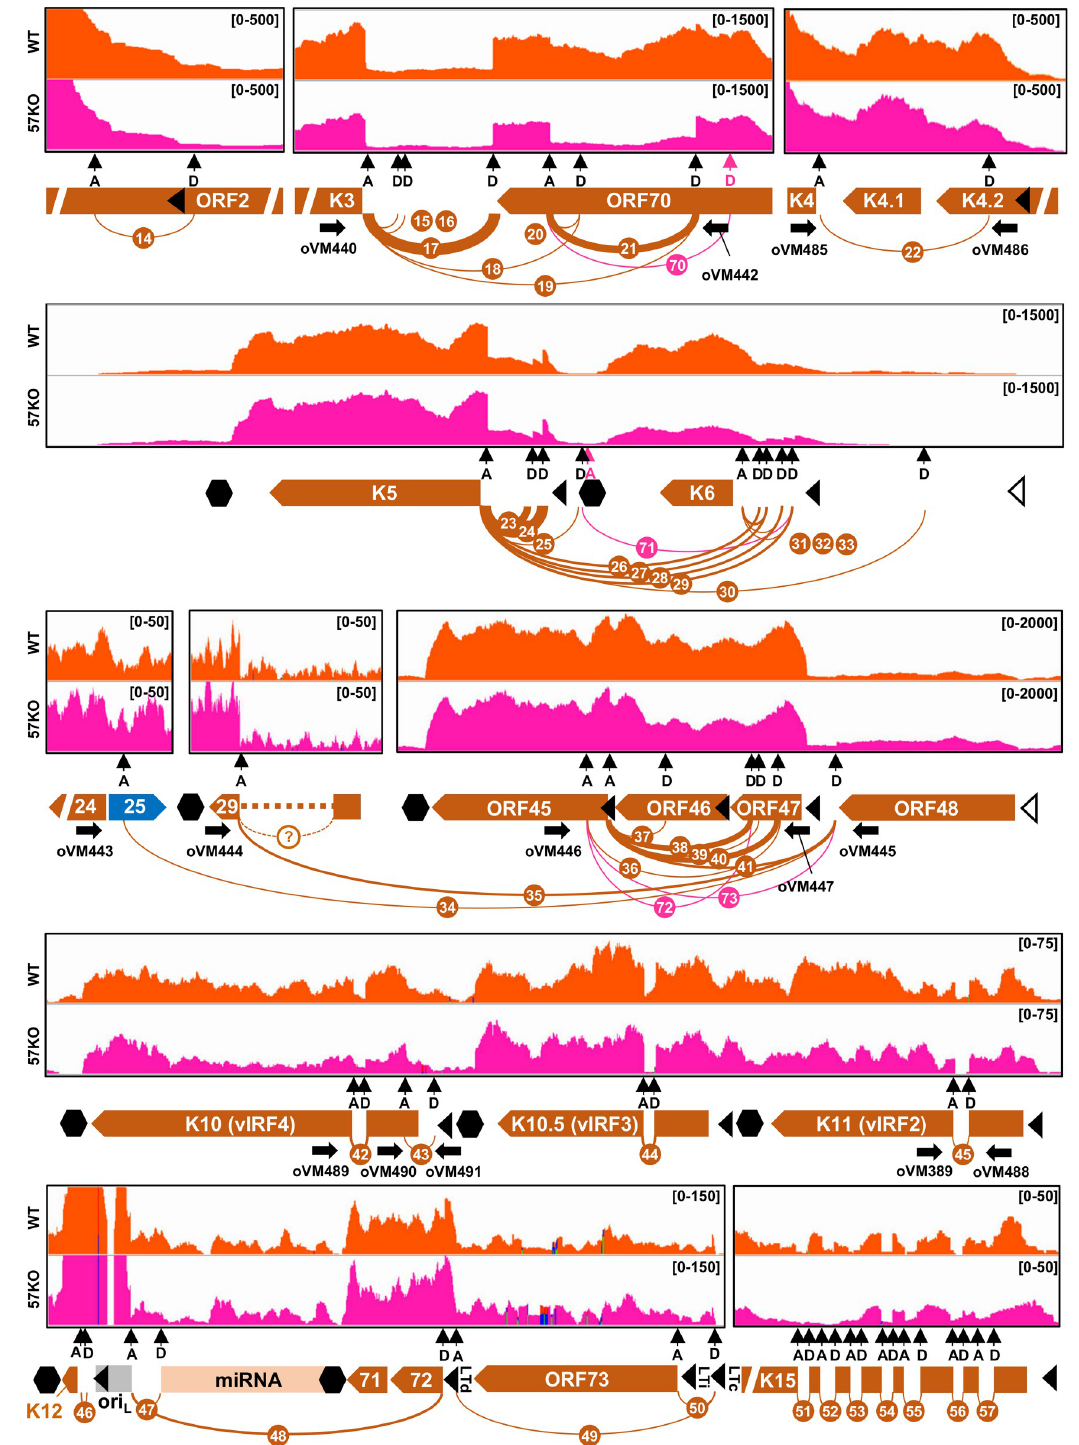
Fig 4. Mapping of KSHV RNA splice junctions from the minus strand of viral genome. The diagrams depicting all splice junctions (colored arches) with � 10 supporting splice reads mapped to viral transcripts expressed from the minus strand of the KSHV genome, with the splicing events being numbered in the order from the genome 5 0 to 3 0 direction. The numbered orange arches represent splice junctions detected from the WT genome and pink arches from the 57KO genome in the cells (see Tables 1 and 3 ). The arch thickness represents a relative abundance of detected splice junction reads. The RNA-seq reads-coverage from one